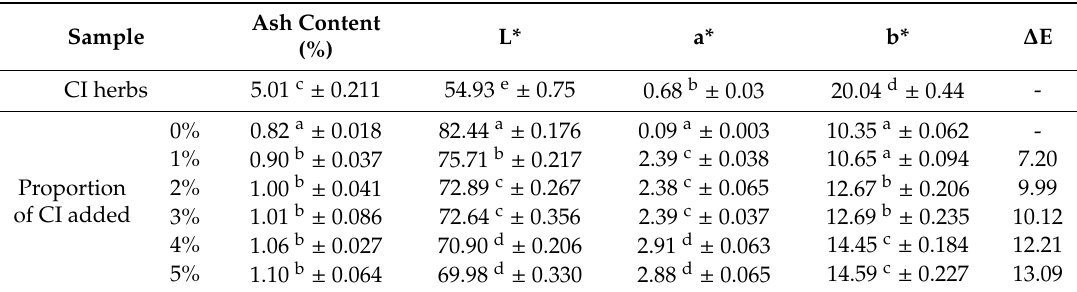
Figure 2. Baking properties of bread enriched with Cistus incanus L. additives. ( a ) yield of bread, ( b ) baking loss, ( c ) volume of bread, ( d )porosity of bread, ( e ) acidity of bread, ( f ) moisture of bread,. Table 1. Ash content and color parameters of Cistus incanus L. (CI) and bread samples supplemented with this